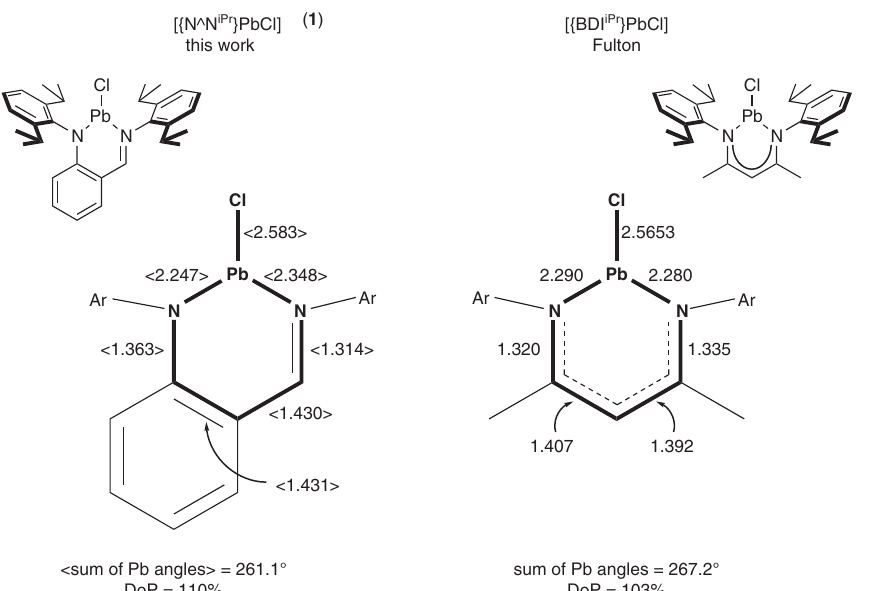
Figure 5: Comparison of interatomic distances (Å) and angles between [{N^N iPr }PbCl] ( 1 ) and Fulton’s directly related [{BDI iPr }PbCl] (Chen et al., 2007). Average values for the two independent components 1a and 1b are given for complex 1